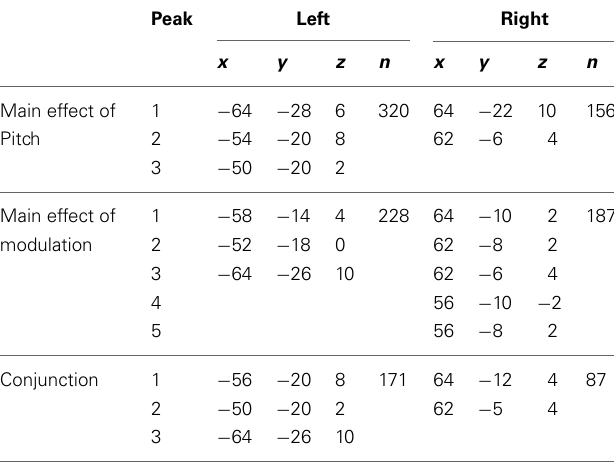
Table 2 | Location (MNI coordinates) of the effects of pitch and modulation, and of the conjunction between pitch and